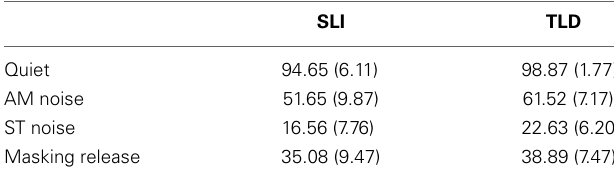
Table 6 | Mean percent correct responses for AO in quiet, AM noise and ST noise, and mean values for the masking release effect.